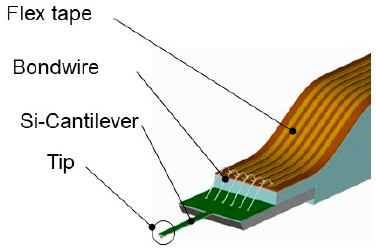
Figure 39. Detailed view of Si-cantilever microprobe, bonding wires, and flex tape for electrical connection [13].